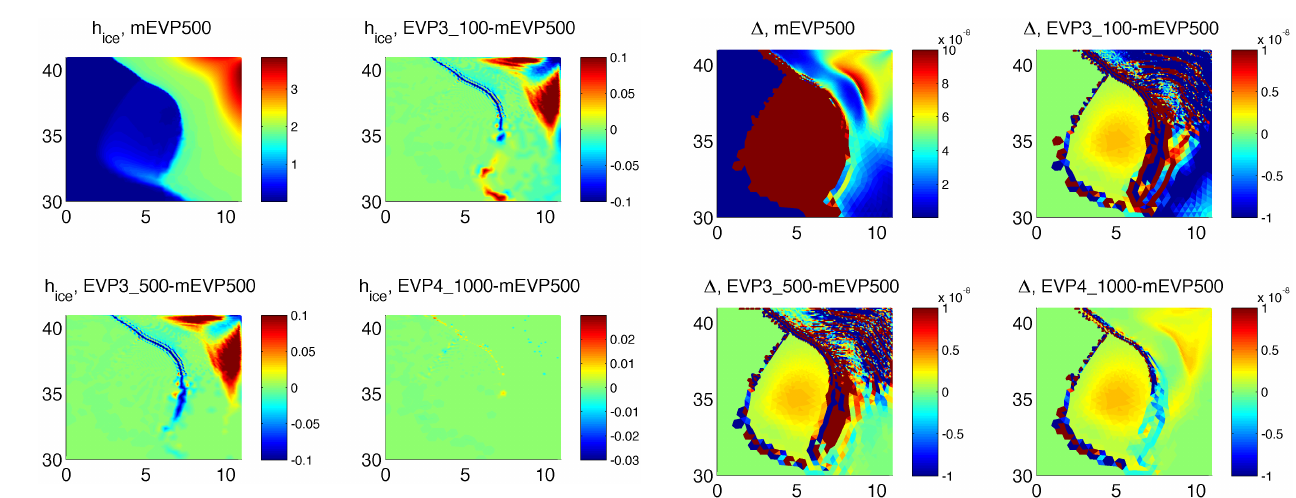
Figure 9. Same as Fig. 8 but for (cid:49) (s − 1 ). Only the special solution obtained with the same decay rates in equations for stresses (bottom right) compares well to the mEVP